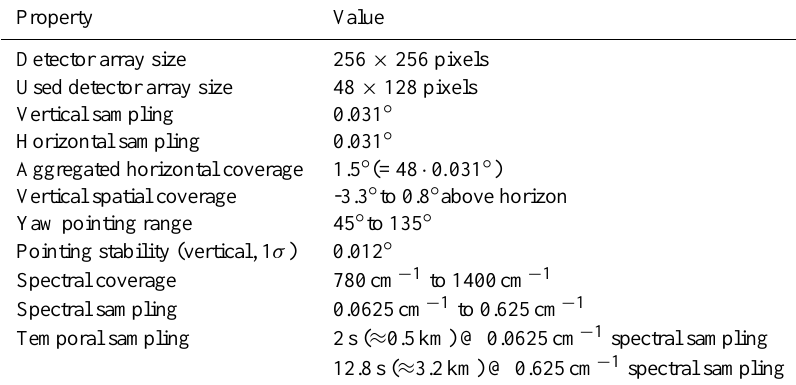
Table 1. Key instrument characteristics and properties (Friedl-Vallon et al., 2014).